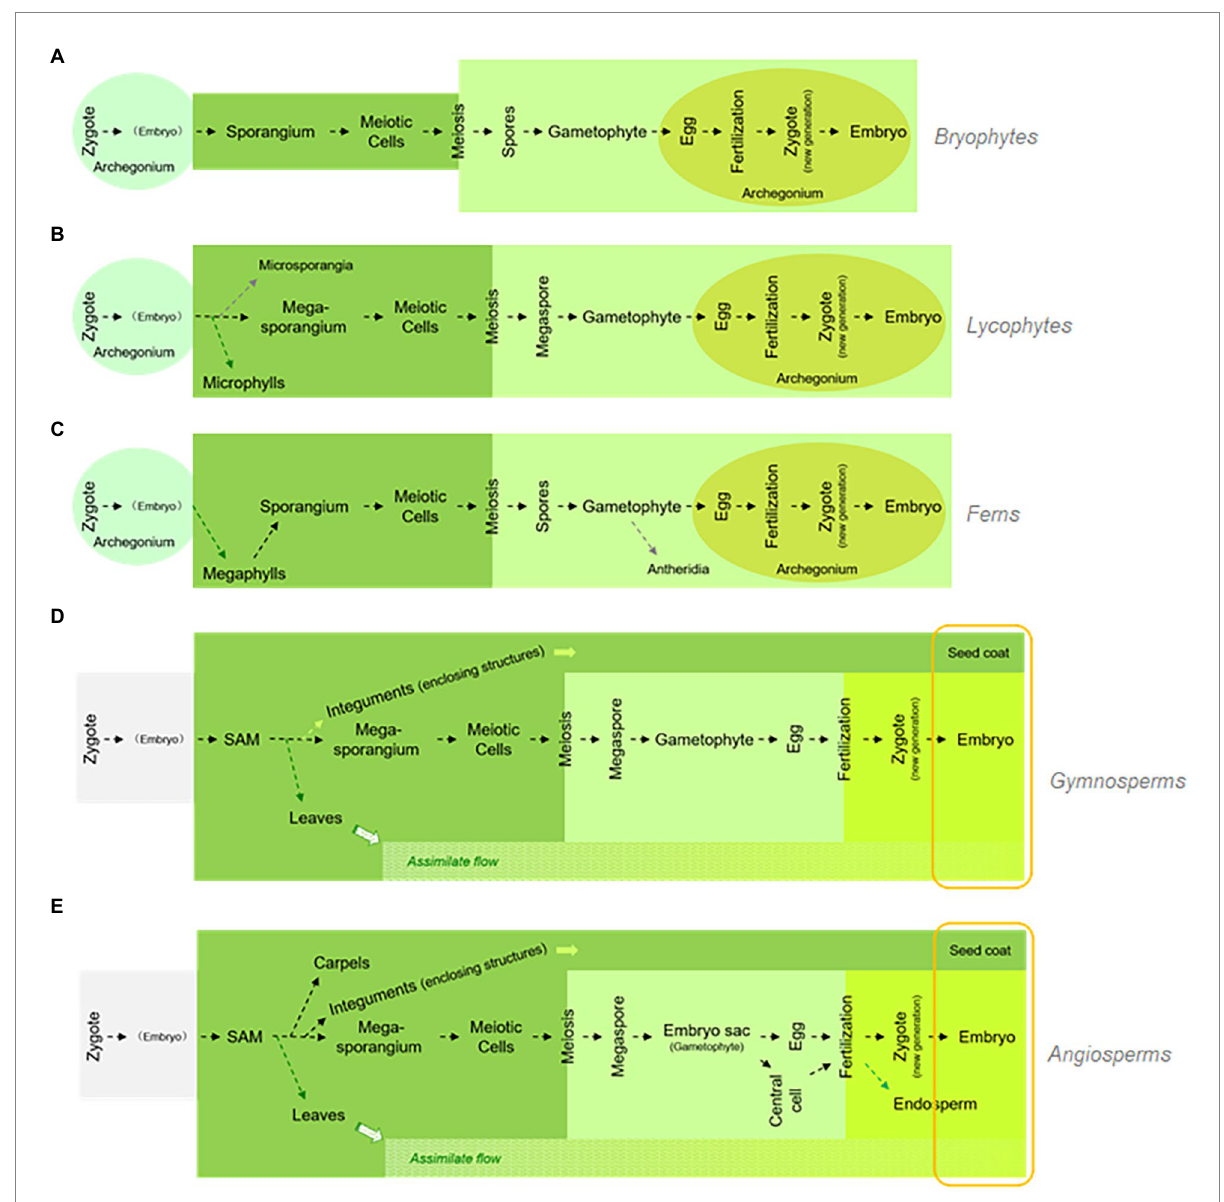
FIGURE 7 Life cycle comparison among five major land plant groups and key evolutionary innovations. The five major land plant groups are bryophytes, lycophytes, ferns, gymnosperms, and angiosperms, labeled from A–E , respectively. While the successful development of a seed plant requires integration of multiple evolutionary innovations, these innovations may emerge independently, regardless of seed origin (labeled in round- cornered rectangular, compares to Figure